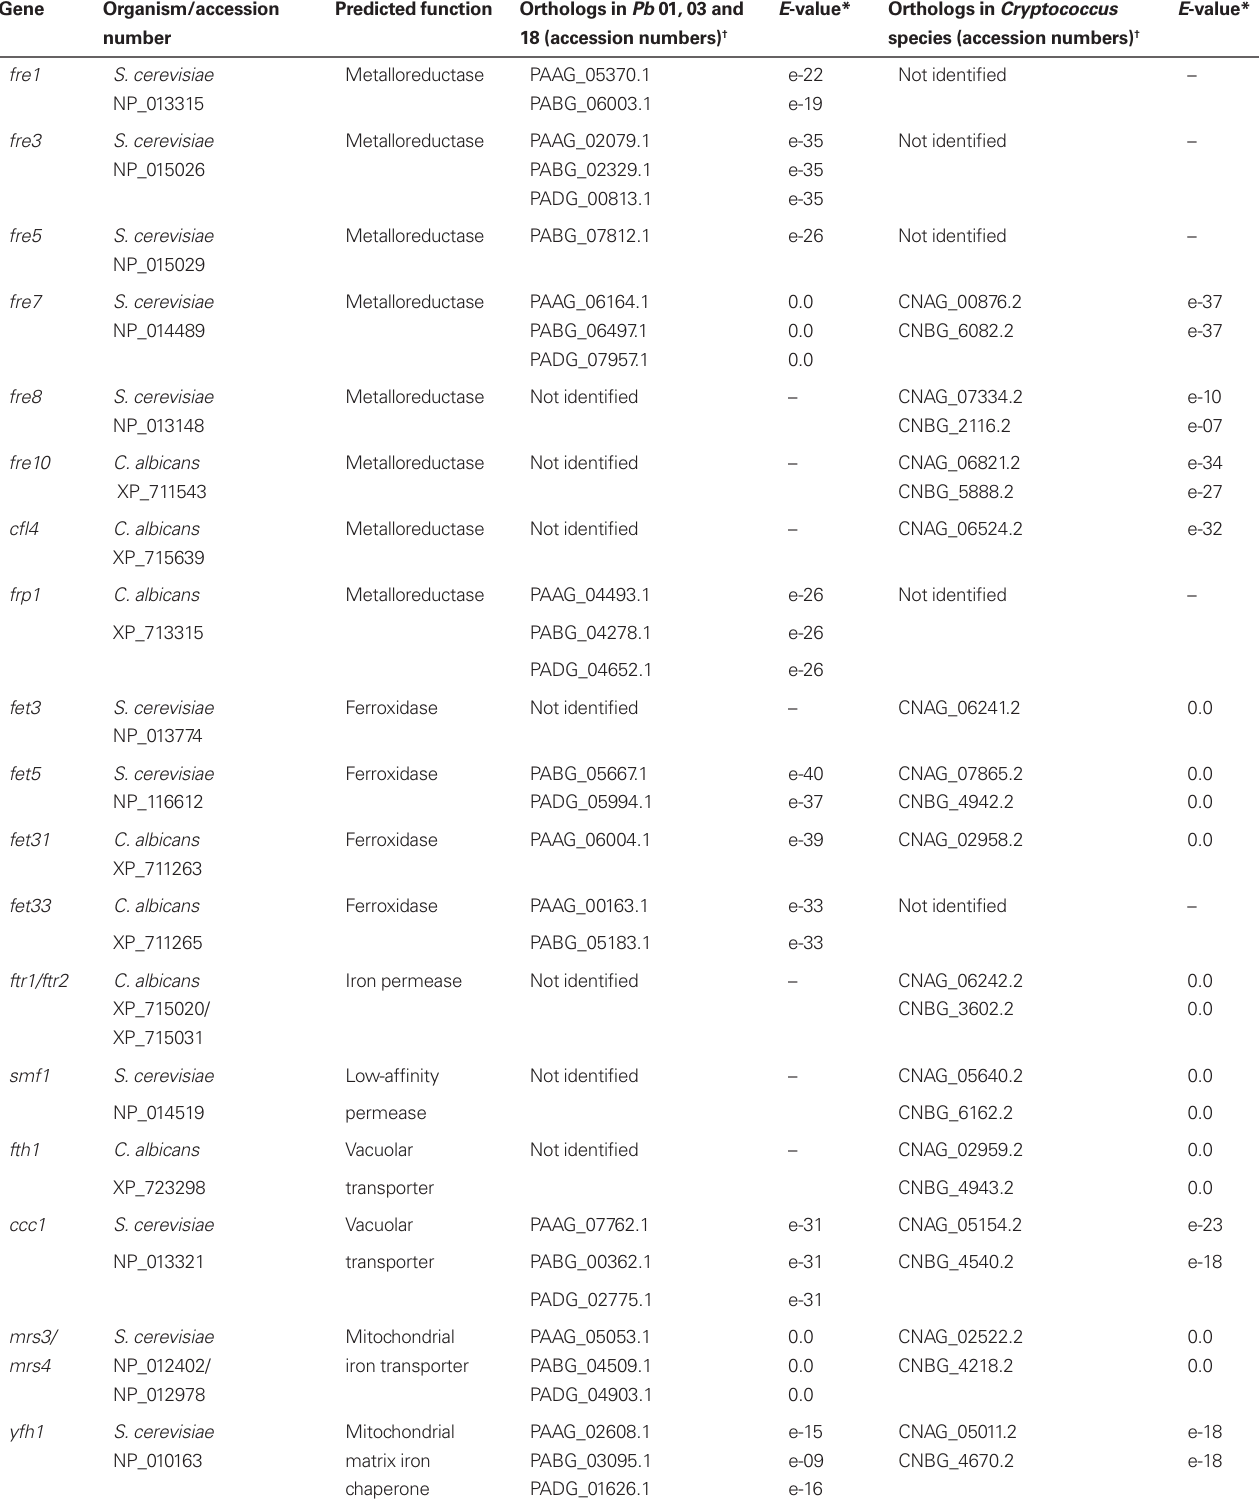
Table 1 | Orthologs to genes related to iron, copper and zinc uptake by reductive systems in P. brasiliensis and Cryptococcus species .